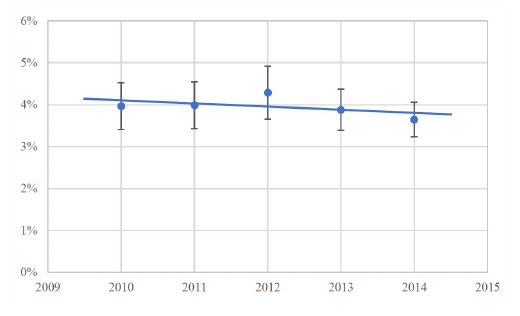
Figure 3: Prevalence of diabetes mellitus 2010–2014 with 95% confidence intervals (CIs) and a linear regression (y = −0.0007x